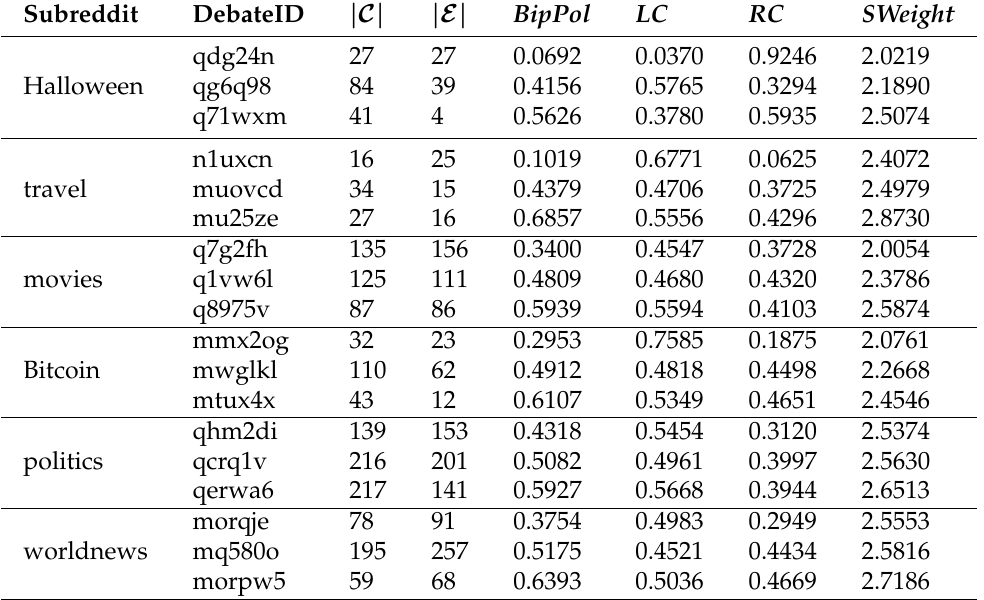
Table 2. Results for the min/median/max values of BipPol of the same debates of Table